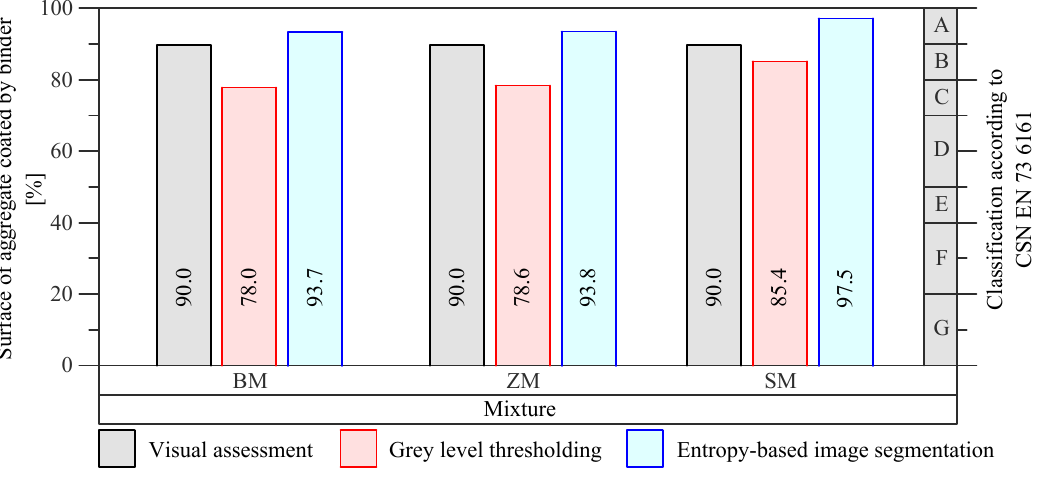
Figure 3. Assessment of adhesion between modified bituminous binder and three types of